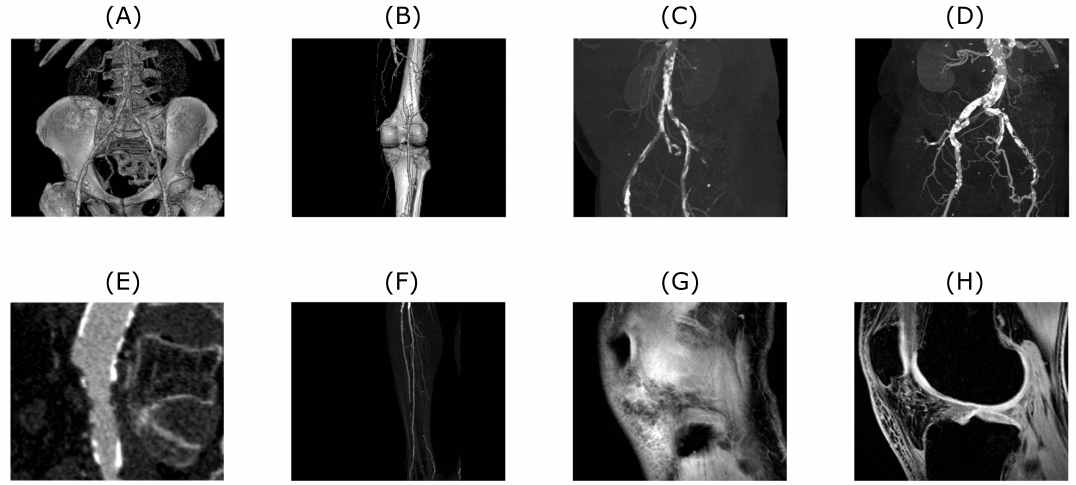
Figure 1. Examples of CT ( A – F ) and MRI ( G and H ) scans used to test the proposed algorithm. Tested images are showing various level of magnification and amount of detail. Also, native noise levels contained within these images are different. Images ( A – F ) are depicting blood vessel calcification in different details and perspectives, whereas images ( G – H ) are showing successive slices of knee